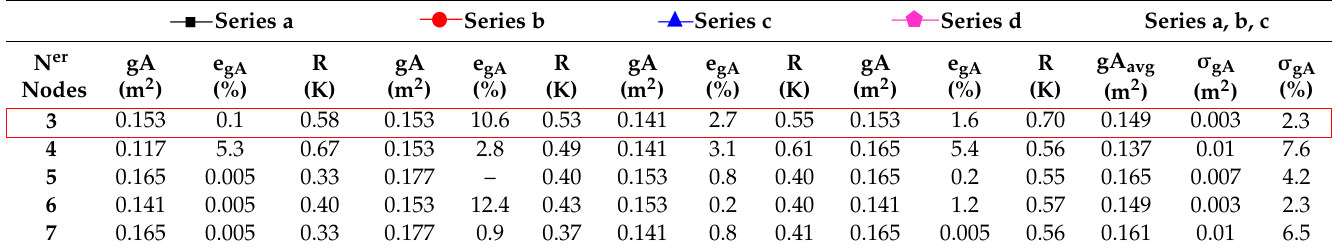
Table 11. Whole building. Summary of results. Output: T i . gA values, and average of the residuals. Where e gA is the error and R is the average of the residuals given by LORD for each data